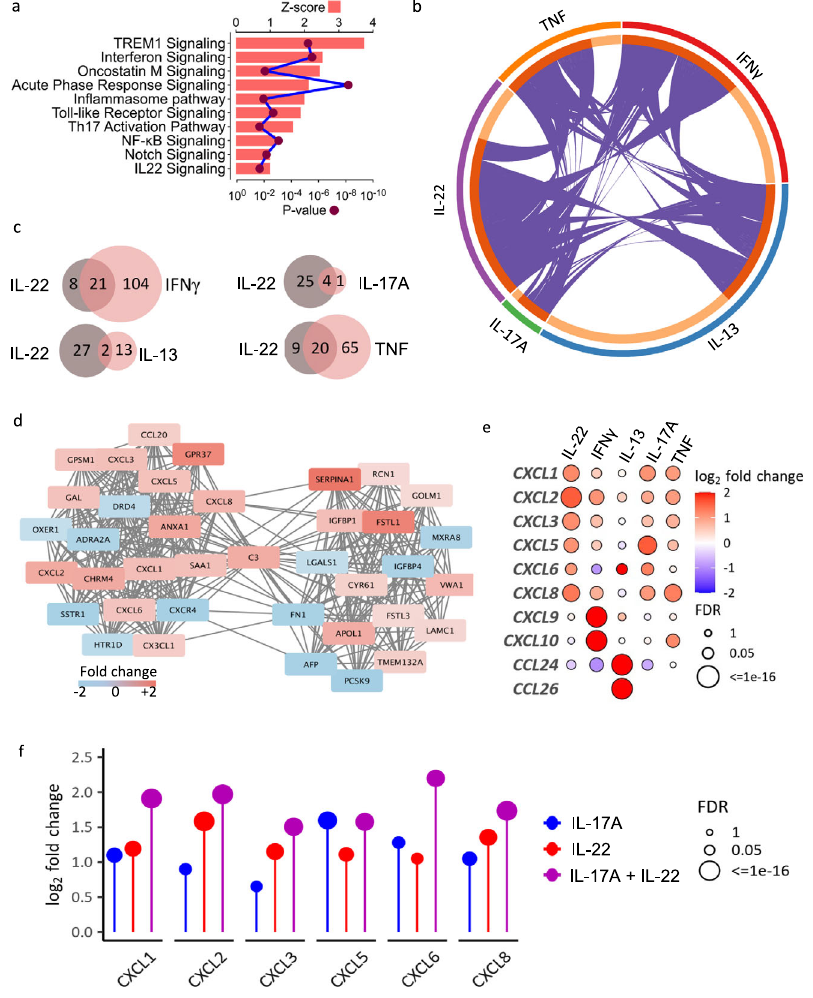
Fig. 3 | Causal network analysis identi fi es induction of neutrophil-active che- mokinesasakeybiologicalactivityofIL-22inthecolonicepithelium.a Top 10 pathways enriched in transcriptional changes regulated by IL-22 in human colo- noids( n =4)asidenti fi ed byIPA, b Circosplotshowcasing theshareddifferentially expressed transcripts regulated by the different cytokines in human colonic organoids (purple lines connecting same genes across DEG lists), c Venn diagrams of shared canonical pathways identi fi ed in IPA between IL-22 and other pro-